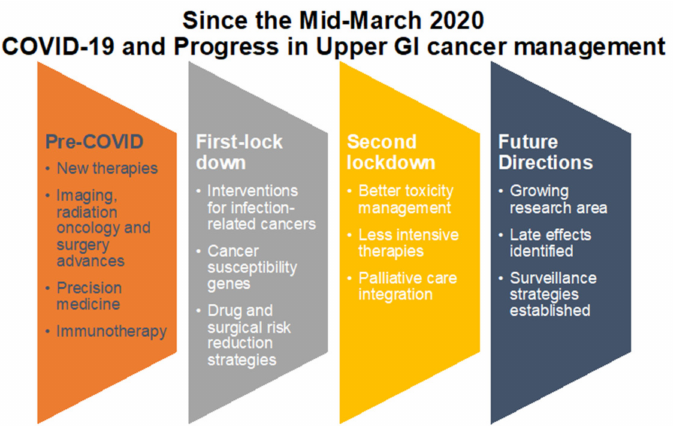
Figure 4. A key priority appears to be succinct triage of patient cases. Extra resources, for example, logistical, administrative or IT services, may be needed to support this clinical activity to both ensure high risk cases are managed appropriately and to avoid using finite resources on low risk cases that could wait. Close, collaborative working between all members of already existing MDTs will be pivotal in addressing the backlog and to manage the expected increase in demand once cancer referral rates return to